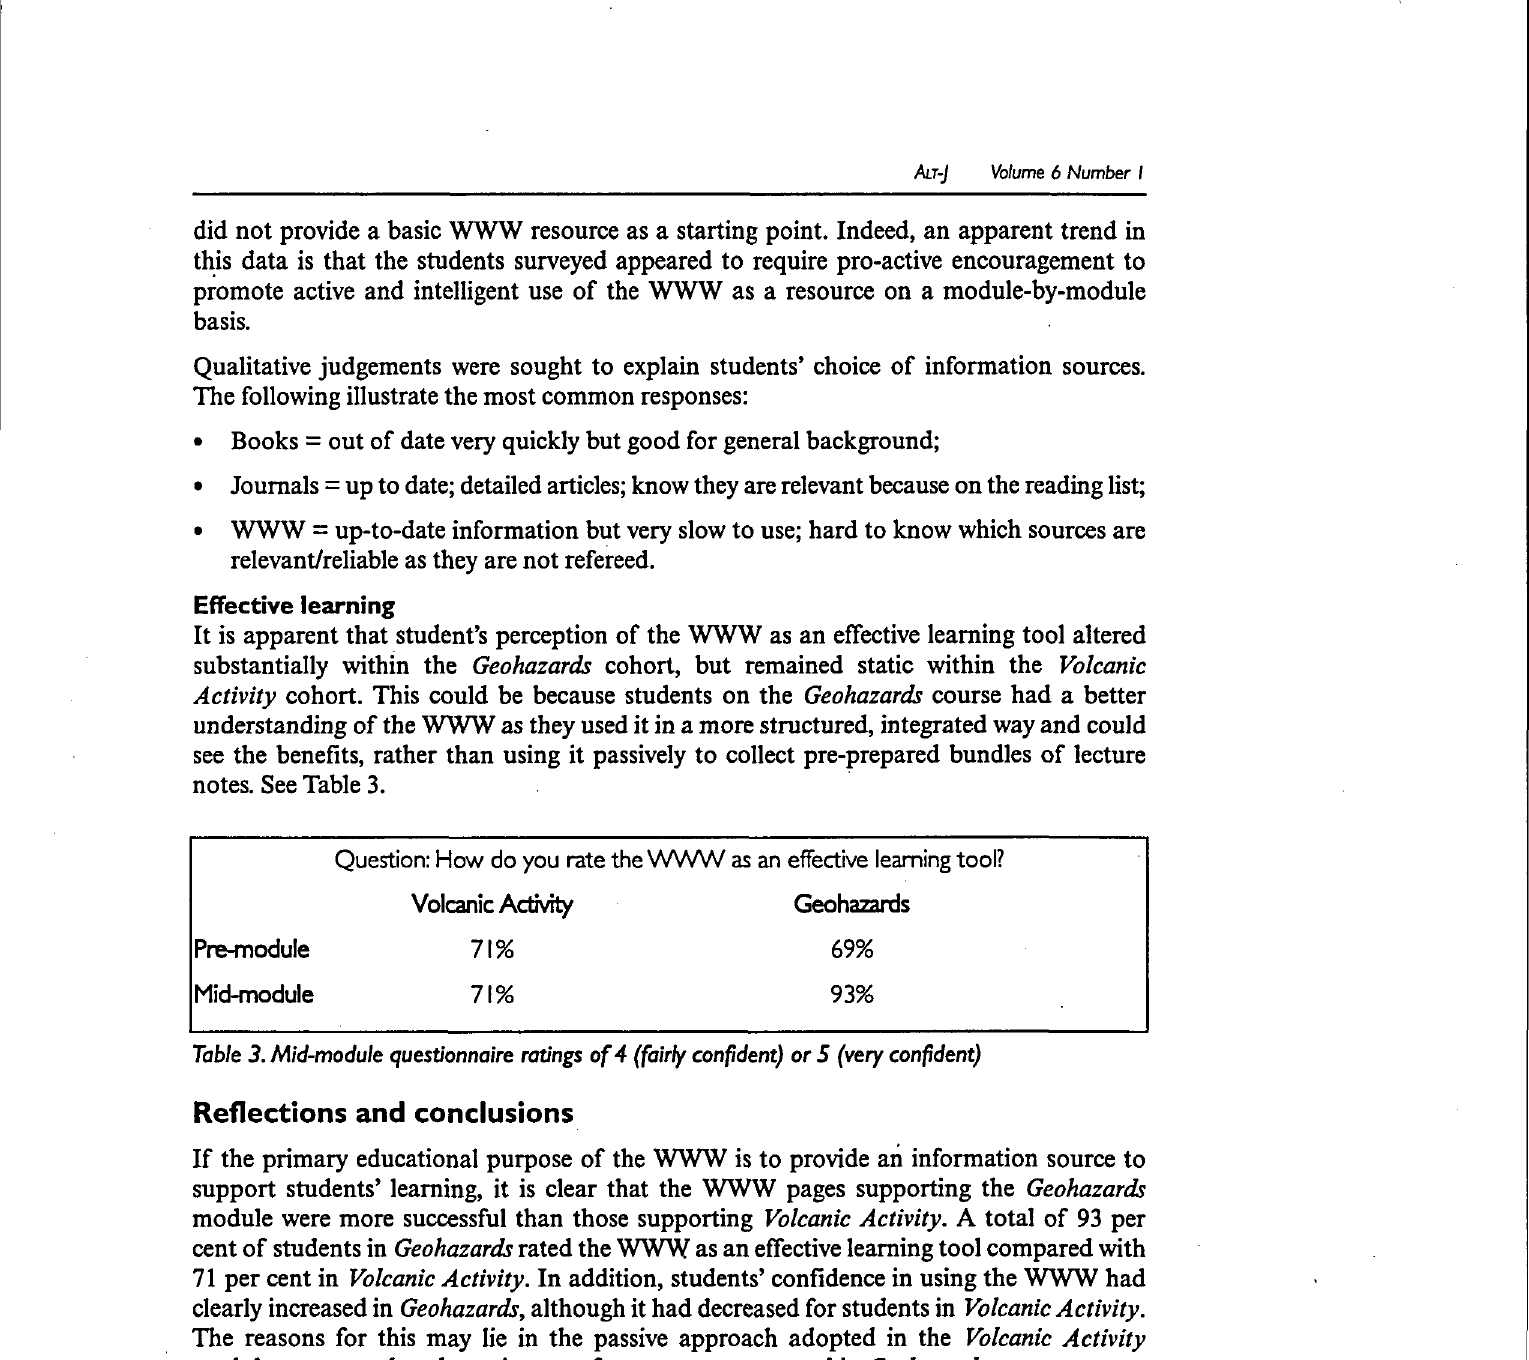
Table 3. Mid-module questionnaire ratings of 4 (fairly confident) or 5 (very